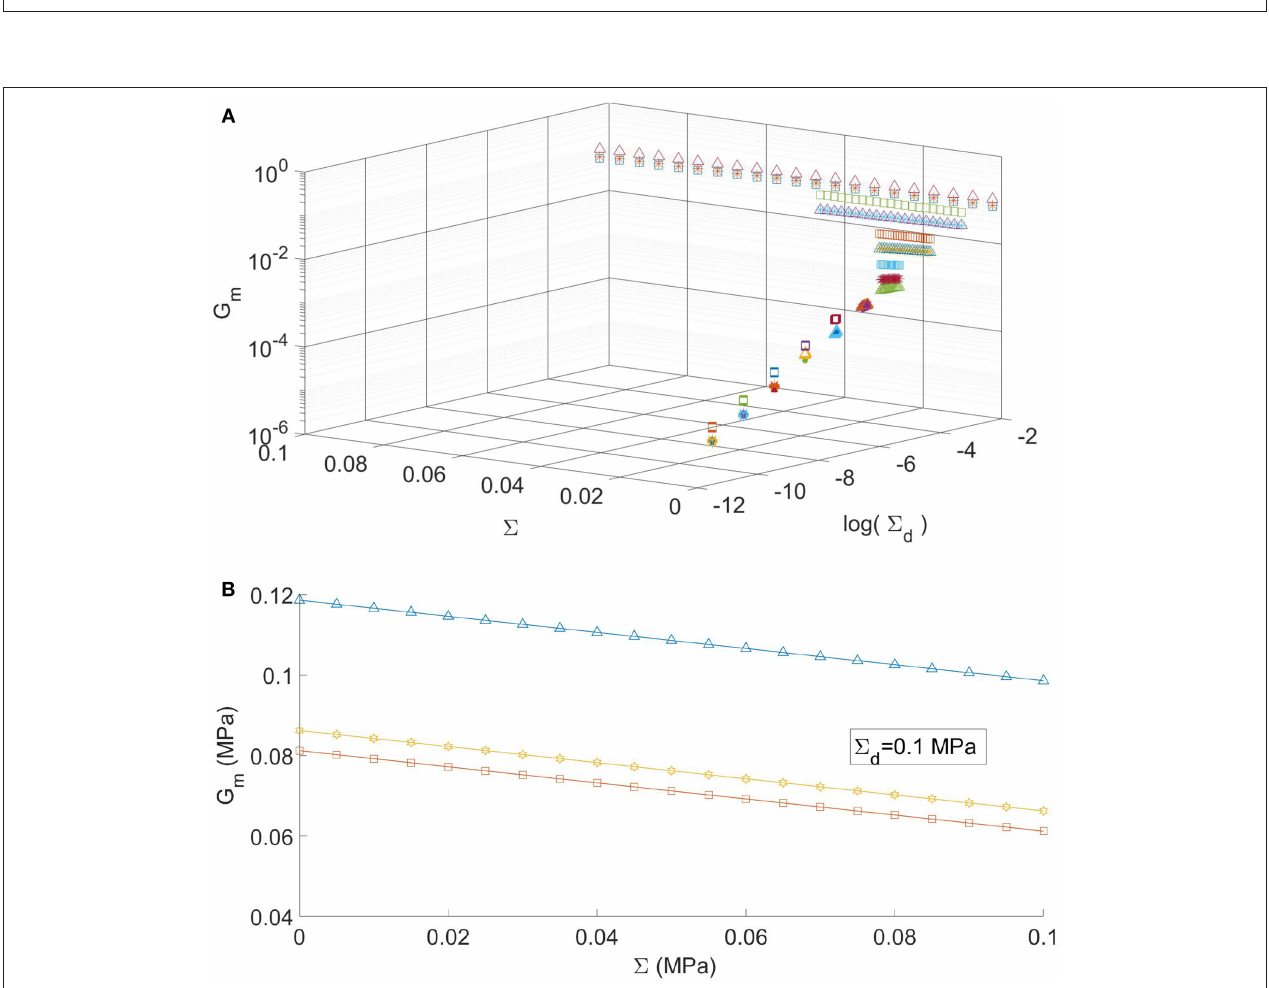
FIGURE 7 | (A) Tangent shear modulus G m vs. the actual macrostress 6 for different values of the design macrostress 6 d . The symbols △ , (cid:3) ,* refer to triangular, quadrangular and hexagonal cells, respectively. (B) Tangent shear modulus vs. the actual macrostress 6 at ( 6 d = 0.1MPa) .